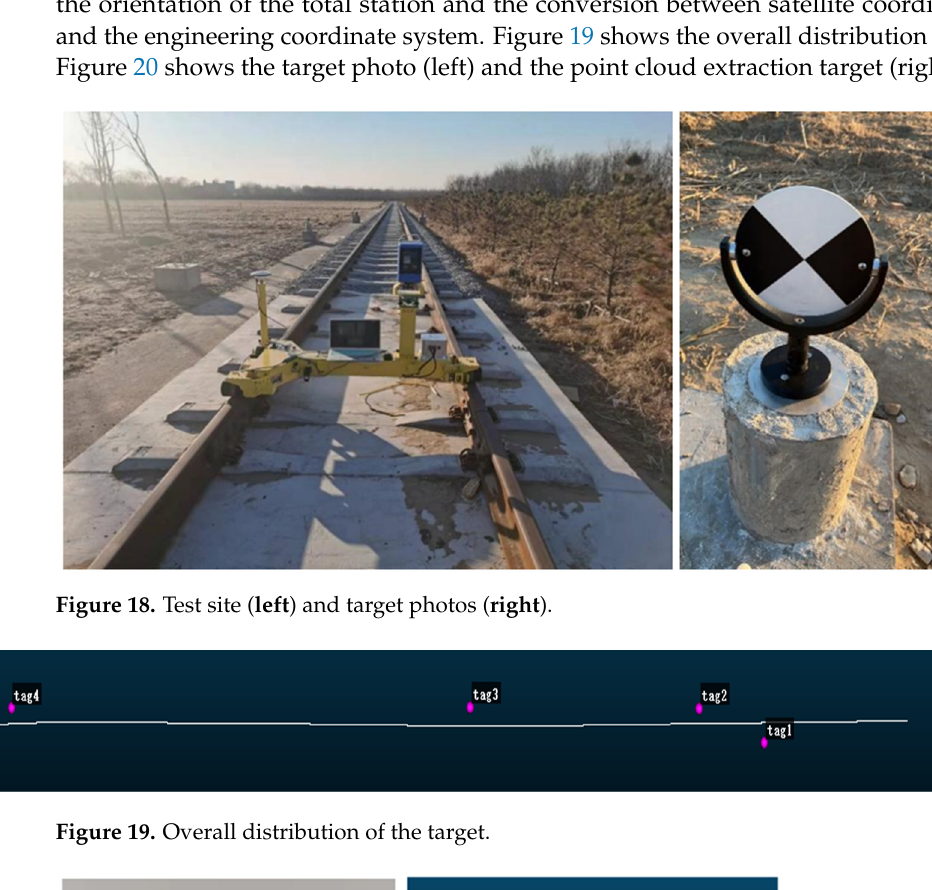
Figure 18. Test site ( left ) and target photos ( right ).